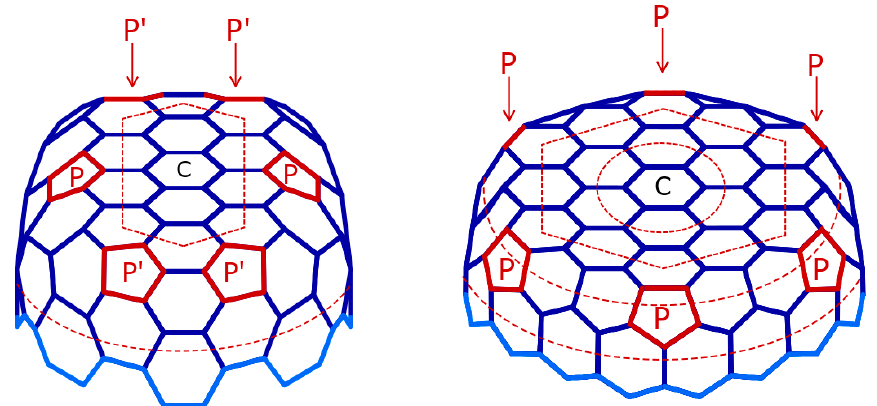
Figure 4. Nucleation and growth of an initial graphene layer on a Ni (111) nanoparticle surface. The graphene layer growth at the borders goes on by bending down. Six pentagons must form at six corners, in a perfect hexagon, or differently when the flat crystal face is oval. Example shown: Two pentagons form in the row, reaching the border earlier ( P ) and four pentagons in next row ( P ′ ).